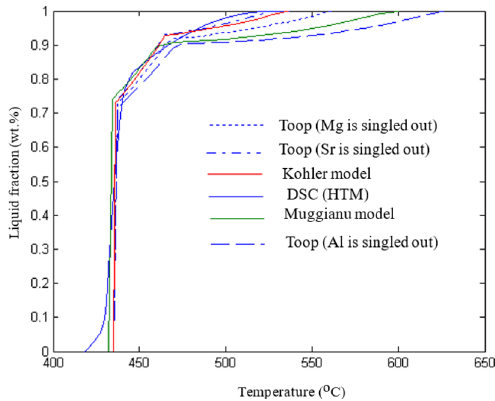
Figure 6. Solidification curves of sample 4 (4.56/31.63/63.81, Sr/ Al/Mg,